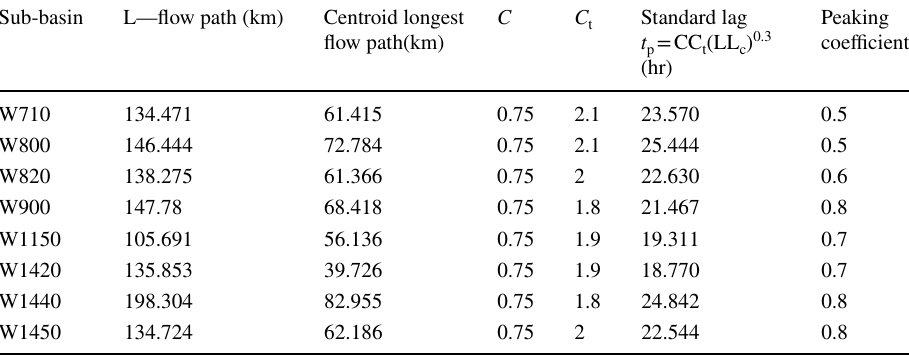
Table 7 Snyder UH initial